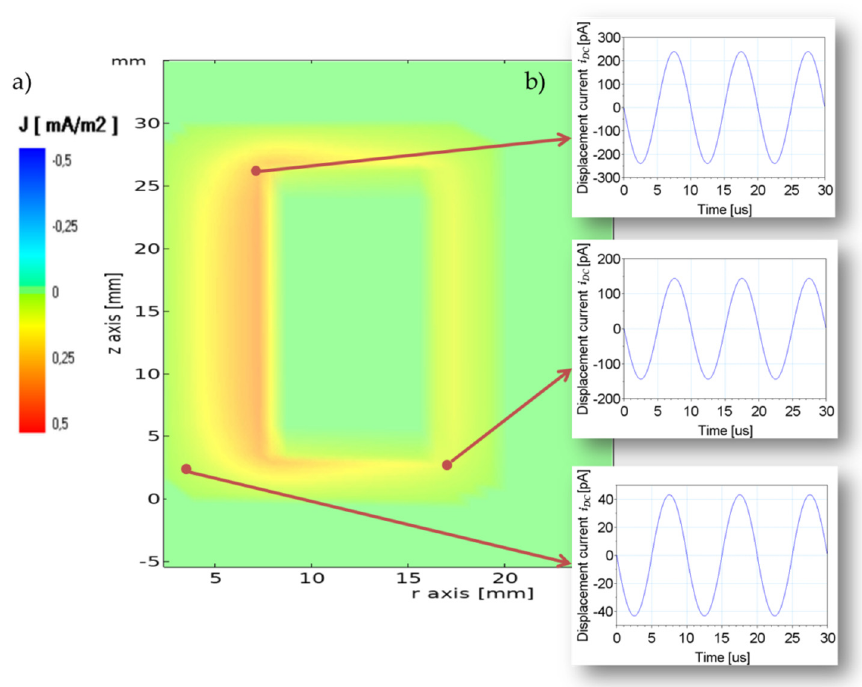
Figure 14. Distribution of the displacement current density in the ferrite core for time t = 7 us ( a ) and the waveforms of the displacement currents i DC for three selected points of ferrite core ( b ) for a frequency of 100 kHz.